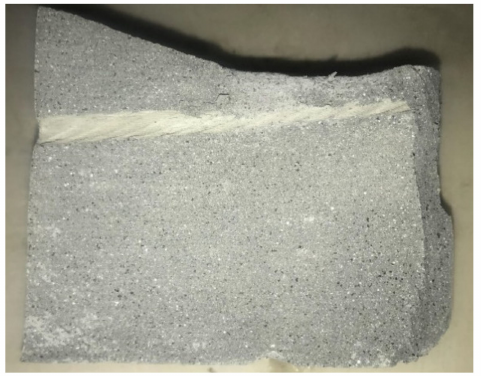
Figure 11. Section diagram of hardened paste of crumb rubber